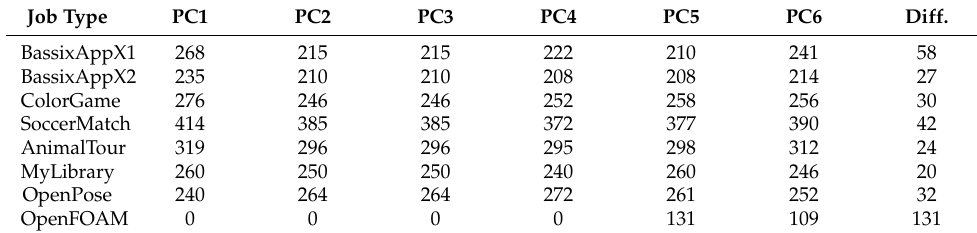
Table 9. T-FCFS makespan detail